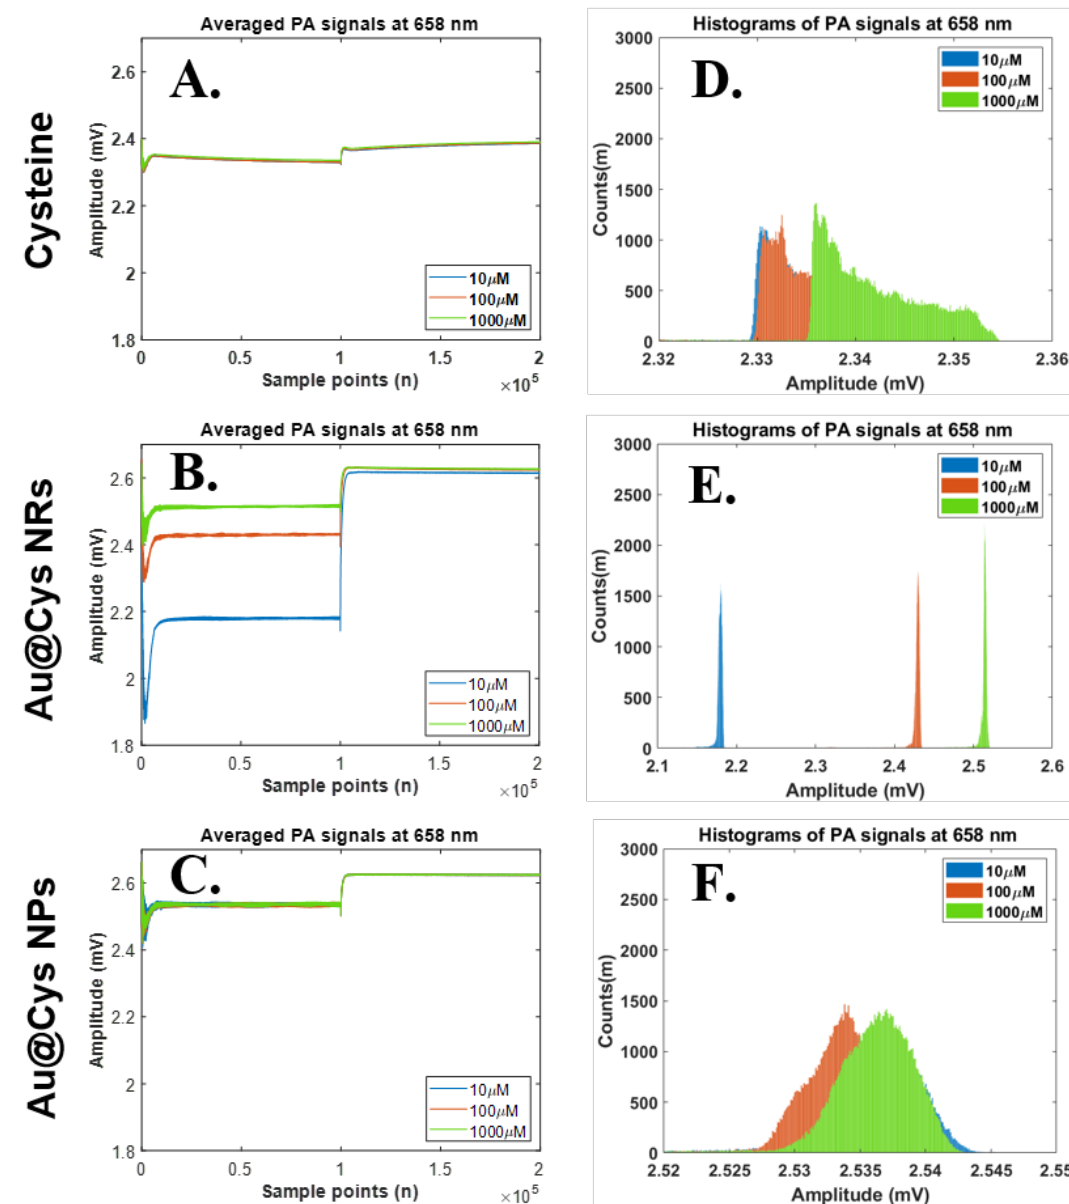
Figure 4. Relationships of time domain PA signals (upper) and their histograms (lower) at the laser wavelength 658 nm. Statistical analysis results of histogram widths among three parameter sets, including 658 nm laser excitation, three substances (Cys, Au@Cys NRs and Au@Cys NPs), and three Cys concentrations (10, 100, and 1000 μM). ( A – C ) Time domain PA signals from Cys, Au@Cys NRs, and Au@Cys NPs samples, respectively; ( D – F ) Histogram plots of PA signals ( A – C ) from Cys, Au@Cys NRs, and Au@Cys NPs samples,